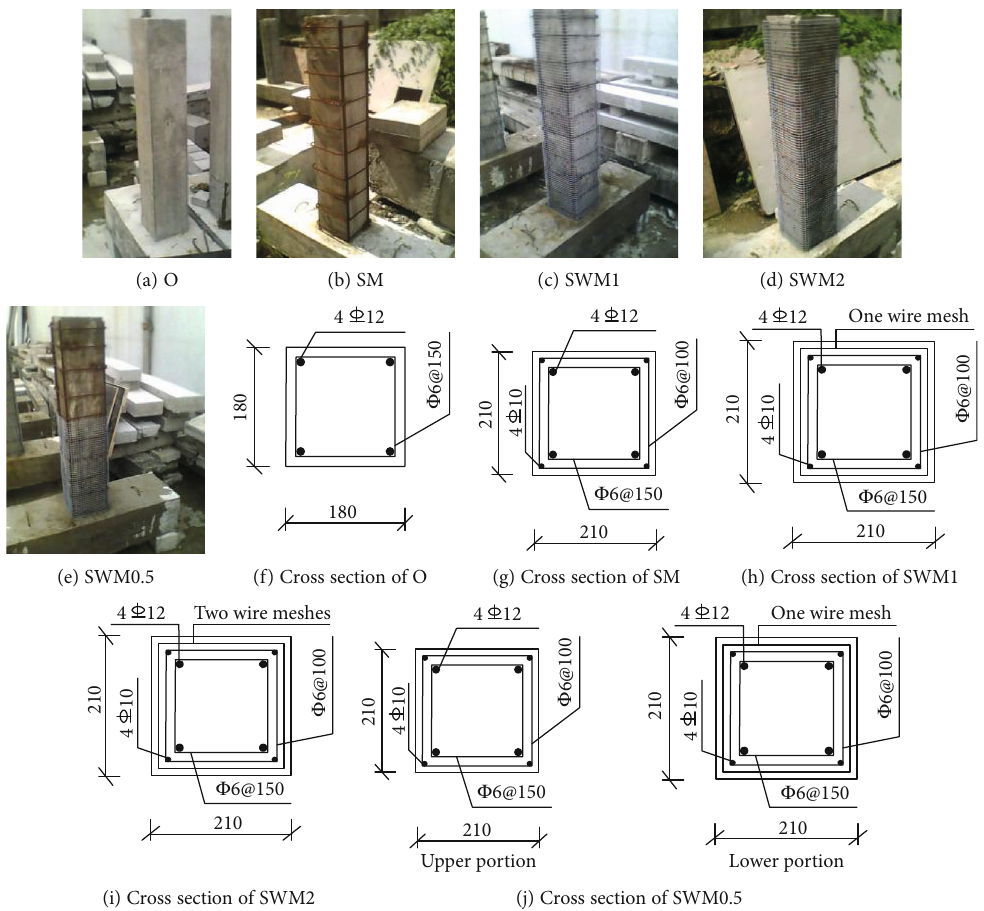
Figure 2: Strengthening details of columns.